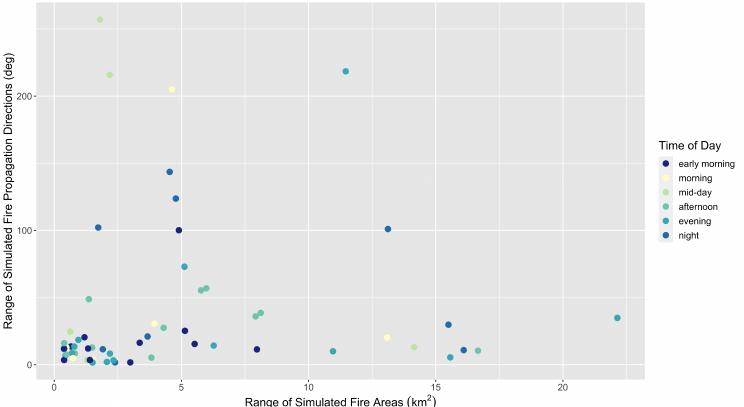
Figure 4. Distribution of range of values for the simulated burned area and propagation directions by distance from the detection point. Each point represents the values for a set of model results initiated from the points 100 m away from the detection point (orange) or 1000 m away from the detection point (blue) at the detection time, six hours before, or six hours after.